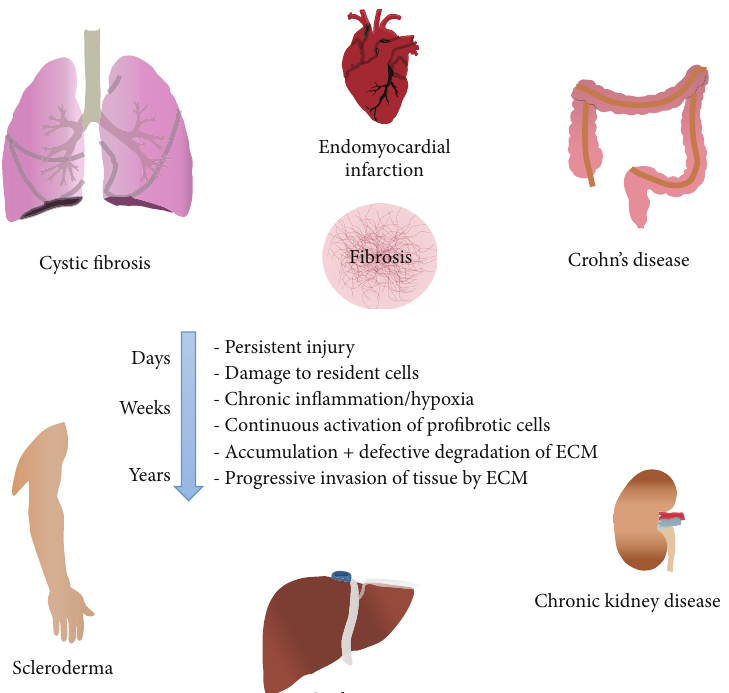
Figure 1: Fibrotic pathologies in various organs. Common features of fibrosis development and progression in various organs and related diseases (ECM: extracellular